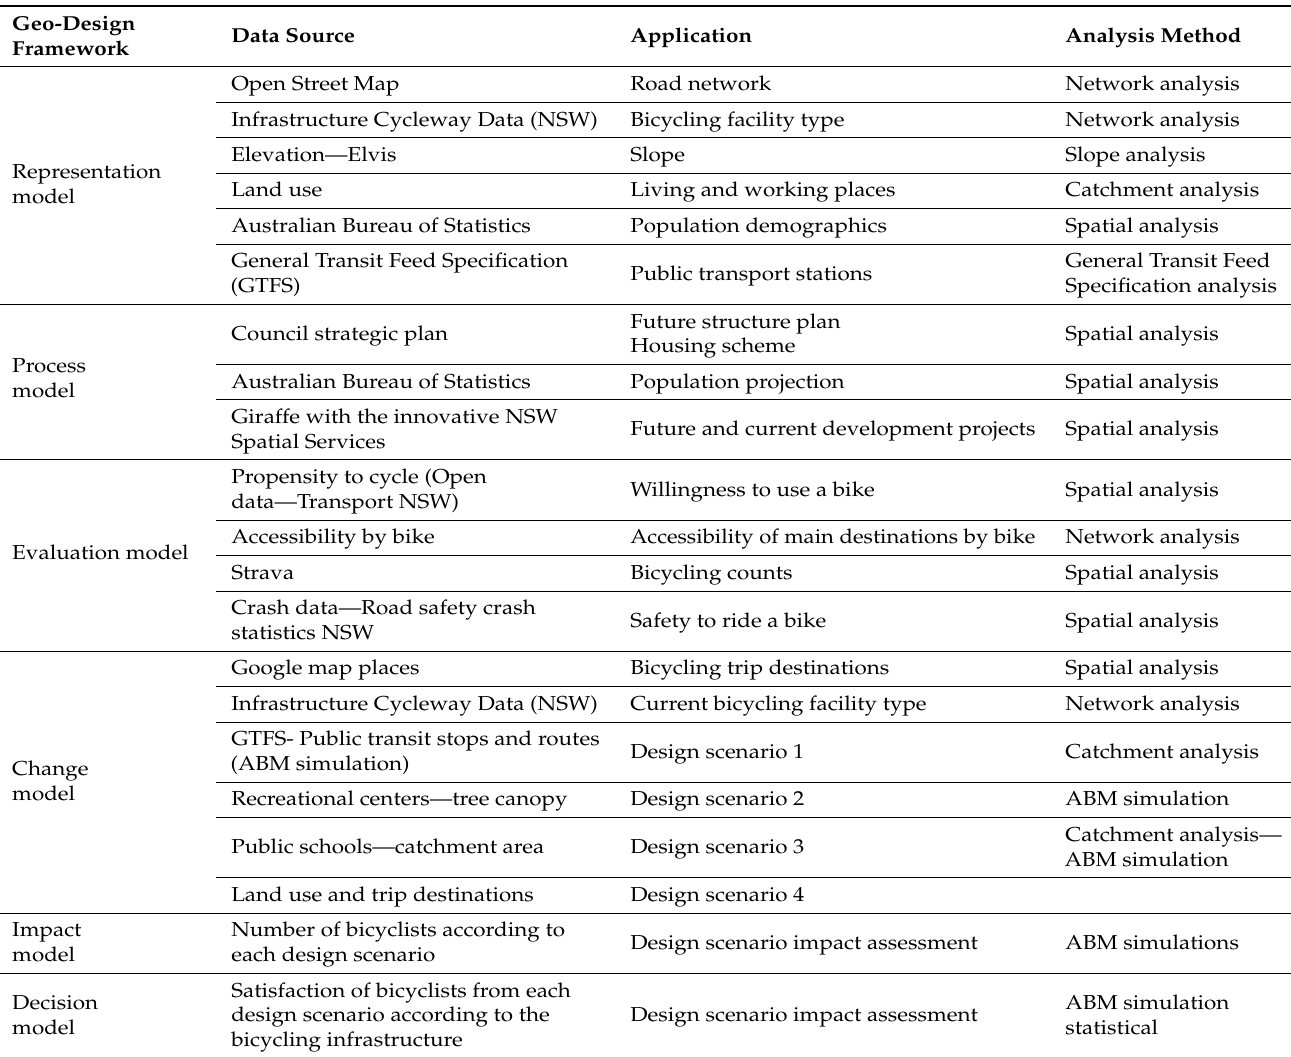
Table 1. Data sources and tools used in the geo-design